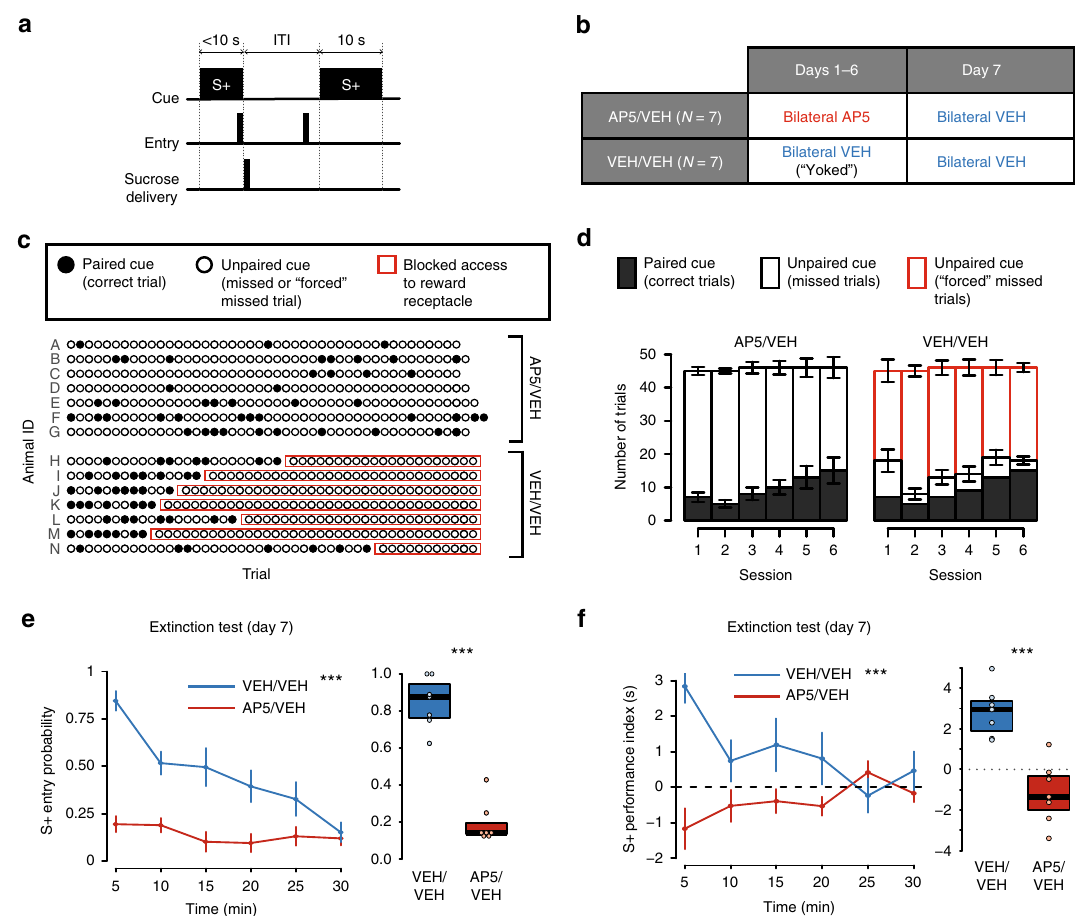
Fig. 5 NMDARs in NAc are necessary for the acquisition of cued approach behavior. a Task. ITI: intertrial interval. b Microinjection schedule. VEH: vehicle. c “ Yoking ” procedure (sample session). Each AP5/VEH or VEH/VEH subject is identi fi ed by a letter. Bubbles indicate trials during which subjects made a cued entry (black) or not (white). Red boxes indicate trials when the receptacle was closed. d Mean ± SEM number of “ Paired ” (black) and “ unpaired cue ” trials (white) experienced on each session by the AP5/VEH or VEH/VEH group. Red bars indicate trials during which the receptacle was closed. Both groups experienced the same number of “ paired ” and “ unpaired cue ” trials daily. e Mean ± SEM S + entry probability in the VEH/VEH (blue) and AP5/VEH (red) groups on the test (drug-free) session (whole session, left; fi rst 5 min, right). No rewards were delivered. There were main effects of the drug, bin and drug × bin interaction (Supplementary Table 1). Box plots show median, interquartile range, and individual values. S + entry probability was lower in previously AP5-treated subjects (*** p < 0.001, t test). f Same as in e but for S + performance index. There were main effects of drug and drug × bin interaction. During the fi rst 5 min, animals that received AP5 injections during training exhibited lower S + performance index (*** p < 0.001; t